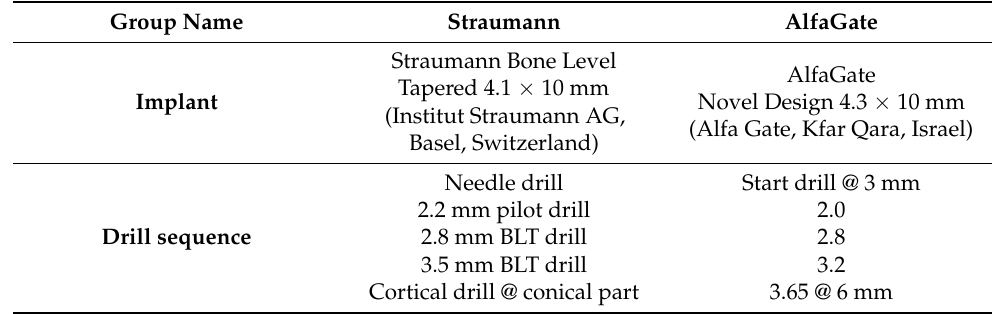
Table 1. Description of the implant systems used in this study and the sequence of drills as recom- mended in the manufacturer-specific guidelines for class III bone. All drills were inserted until a depth of 10 mm was reached unless otherwise specified. All implants were inserted with the surgical motor set at 25